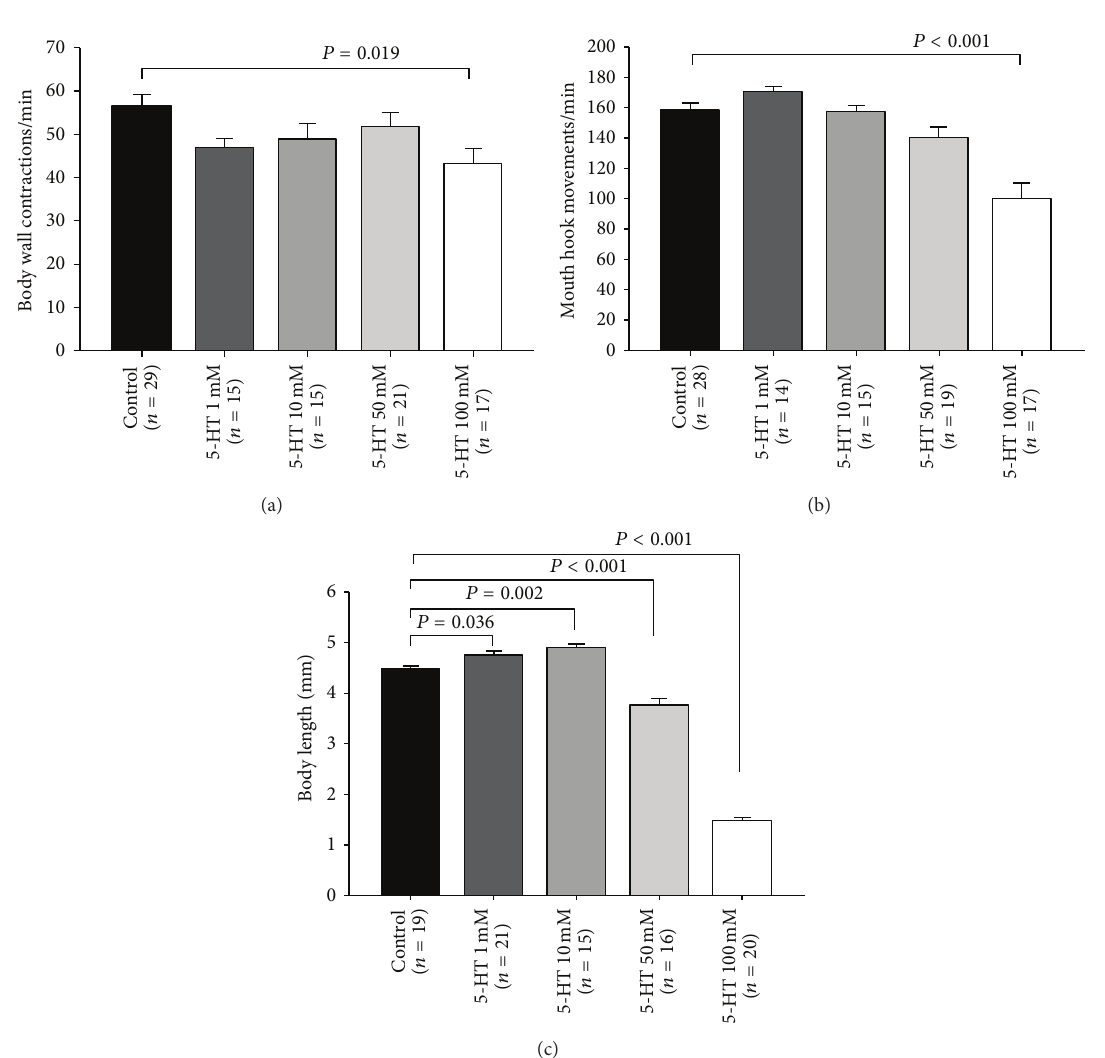
Figure 1: Serotonin modulatory action in feeding and locomotion behavior. (a) Effect of 5-HT on larval locomotion behavior. Canton-S (CS) larvae fed food containing 5-HT at 100 mM had significantly reduced body wall contractions. (b) 5-HT at 100 mM significantly reduced mouth hook movements. (c) 5-HT 1mM and 10mM significantly increased body length. However, 5-HT at 50 mM and 100mM significantly reduced body length in comparison to control animals (CS). One-way ANOVA was used for multiple comparisons, and Bonferroni 𝑡 -test was employed to compare treatments with control group. Data presented as mean ± SEM. 𝑃 value < 0.05 is